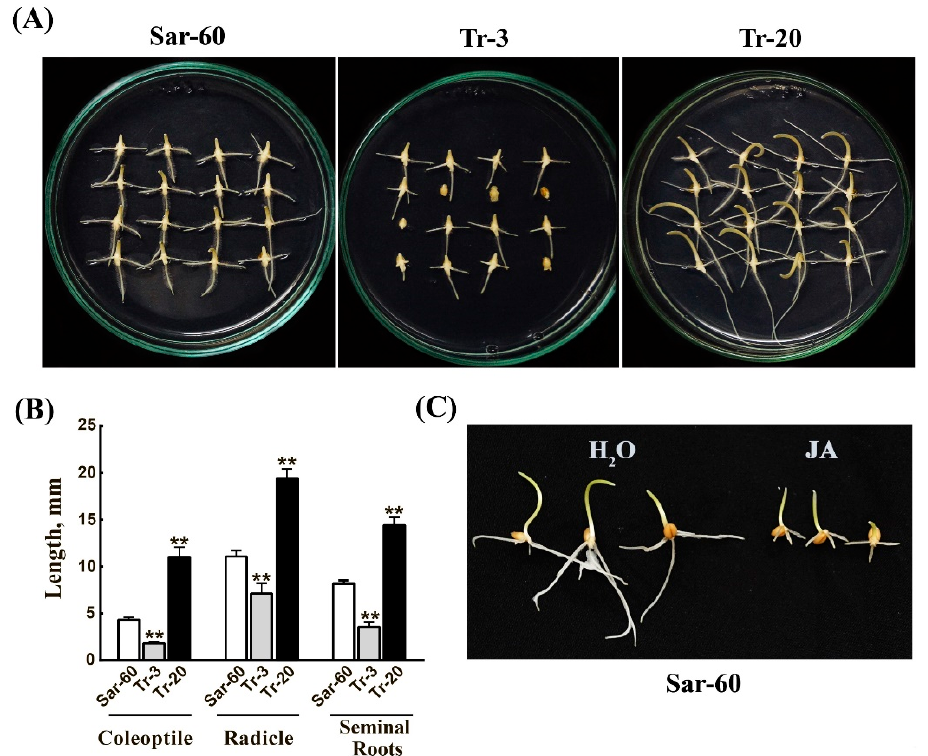
Figure 3. Jasmonate suppresses germination and early growth of wheat. ( A ) The representative Petri plates with seedlings grown from immature embryos of Sar-60, Tr-3, and Tr-20 T3 seeds, four days after culture initiation. ( B ) Length of coleoptiles, radicle and lateral seminal roots of four-day-old seedlings of Sar-60 (white bars), Tr-3 (grey bars), and Tr-20 (black bars). The means of 16 measurements ± SE are presented; stars above the graphs indicate statistically significant difference between genotypes ( p ≤ 0.001). ( C ) Effects of exogenously applied MeJA on the germination and growth of Sar-60 seeds. Seeds were placed on filter paper soaked in distilled water (left side) or a 0.1 mM solution of MeJA (right side); the picture was taken after four days of seed imbibition.